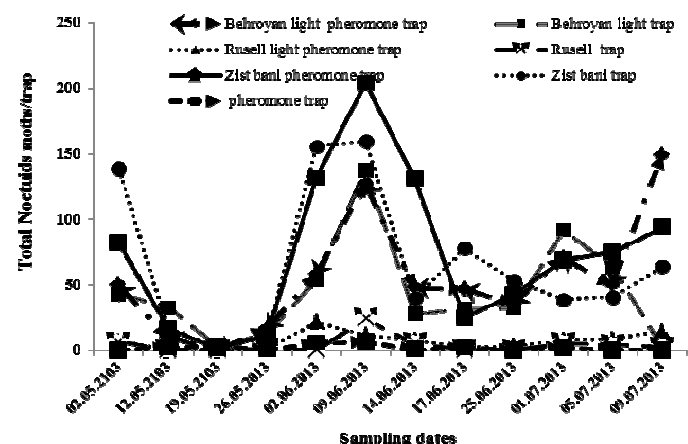
Fig. 3. Population fluctuations of noctuid moths in various traps in different sampling